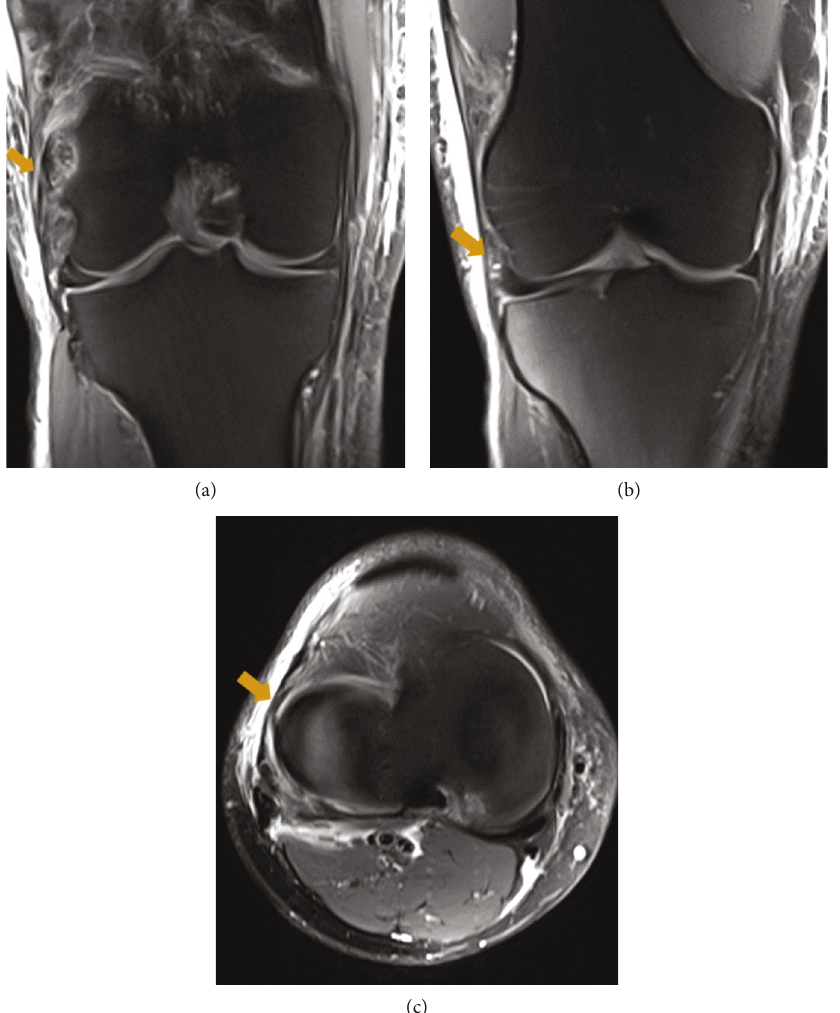
Figure 2: Patient case 2. (a, b, and c) Proton density coronal and axial MRI of the right knee at day 3 showing a loose though intact ALL (gold